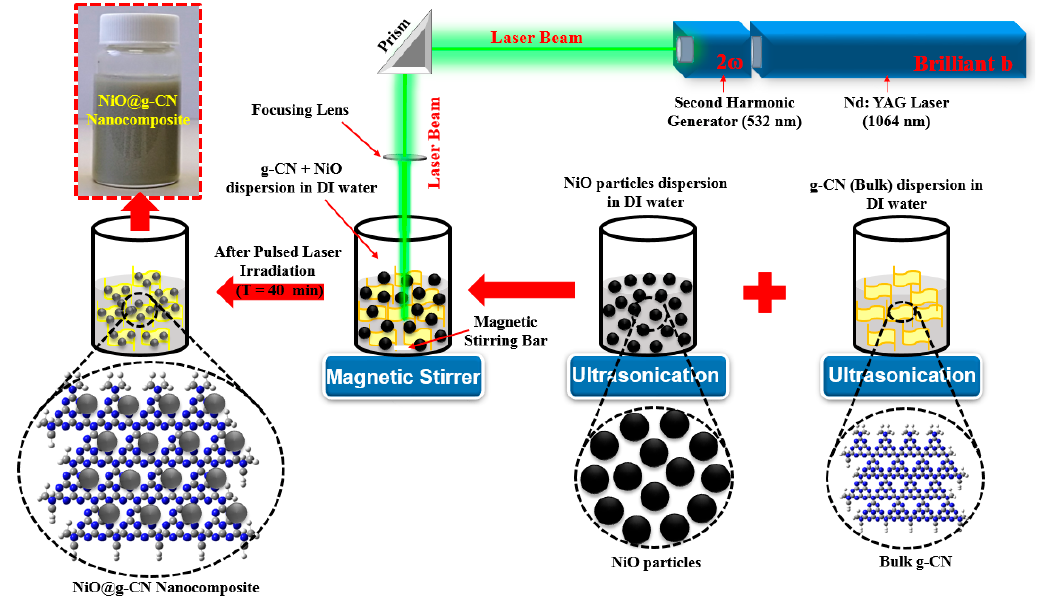
Figure 1. Schematic diagram for the synthesis of NiO@g-CN nanocomposite, using pulsed laser ablation in liquid approach.